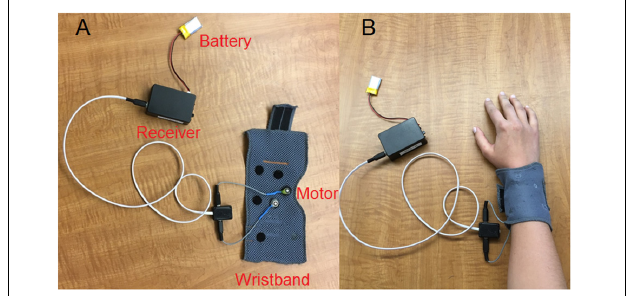
FIGURE 1 | Vibrotactile device used in the present study with the different parts labeled (A) and when the wristband was put around the right arm of a participant (B)